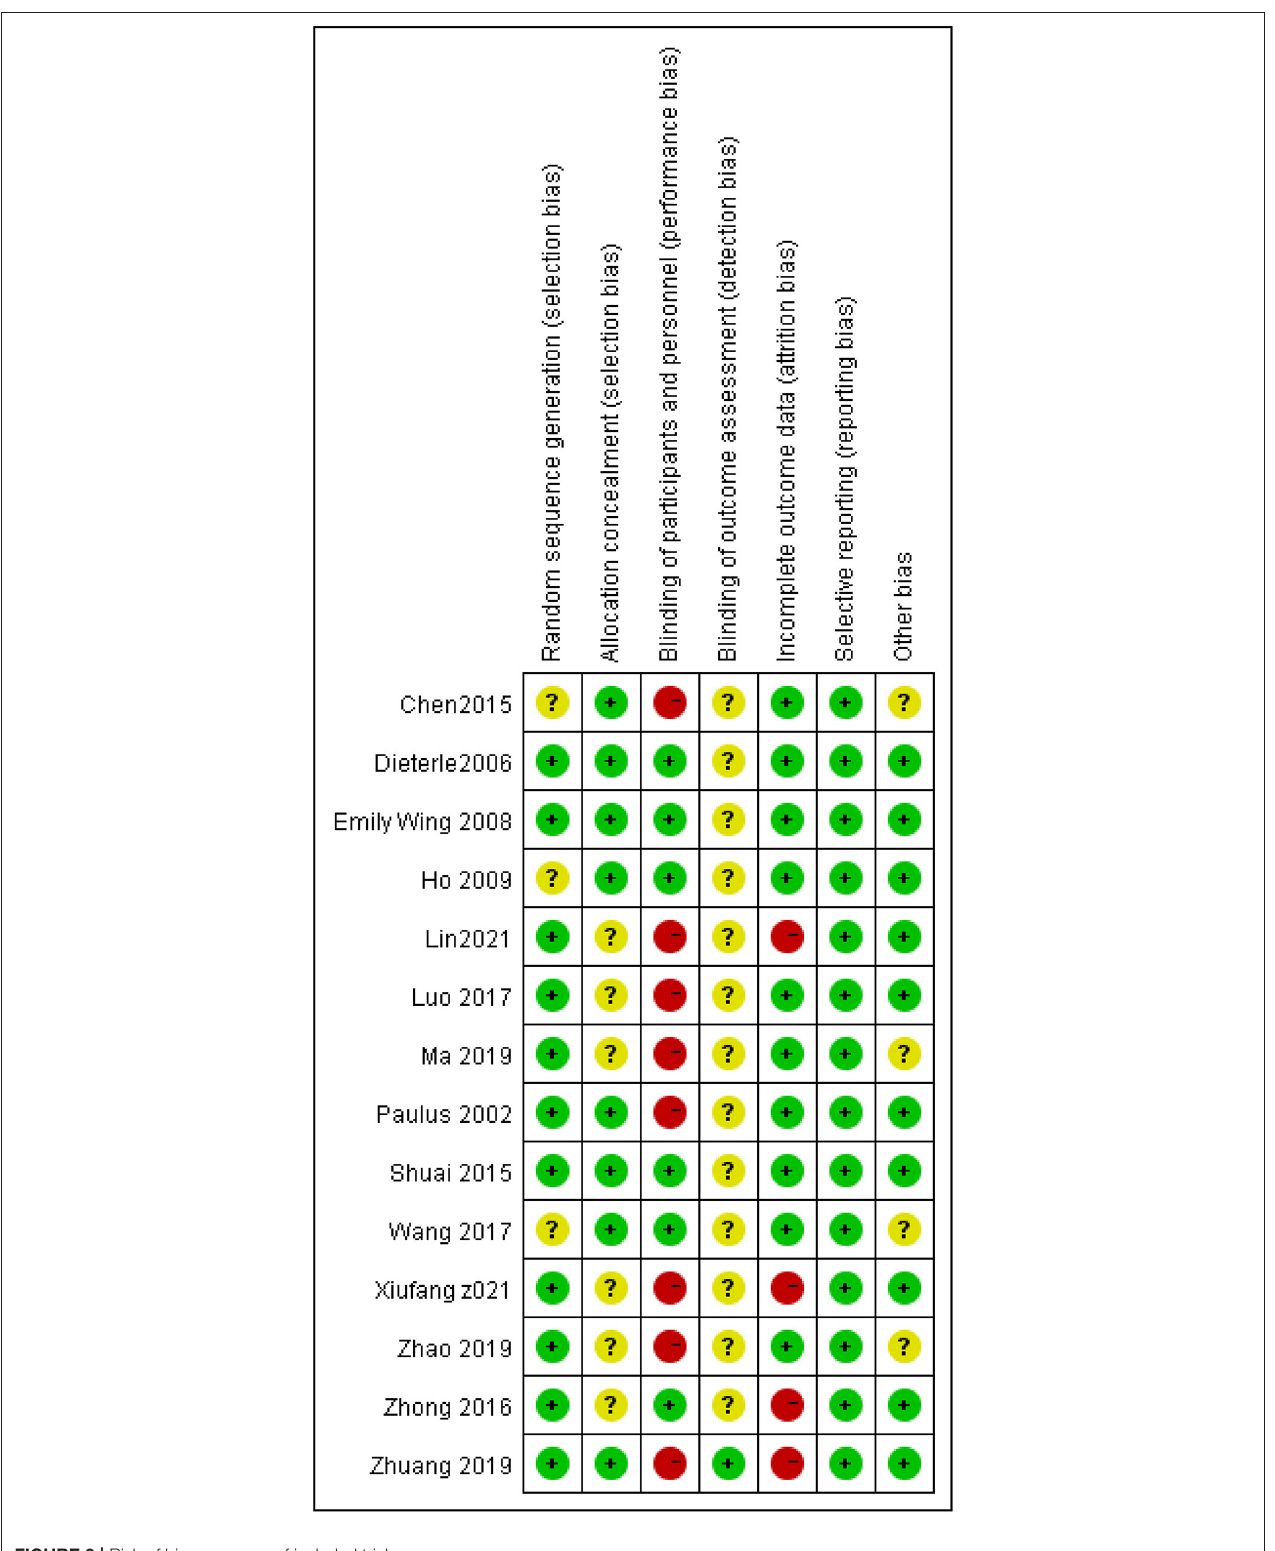
FIGURE 3 | Risk of bias summary of included